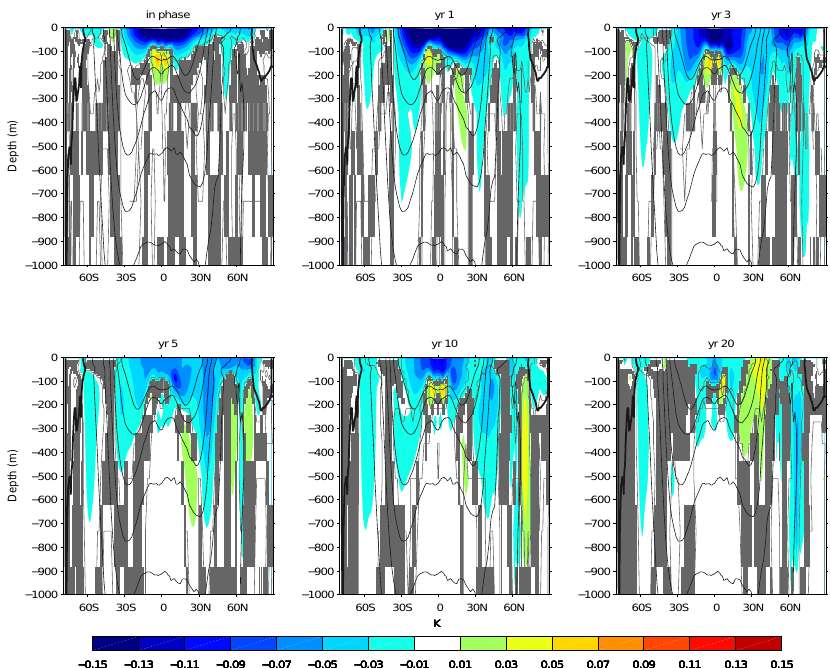
Fig. 6. Composites of anomalous zonally averaged oceanic temperature response at different time lags (in years). Shaded areas are not significant at the 20% level. Grey contours indicate anomalies significant at the 5% level. Dark contours show the zonal mean global temperature (contour interval is 3 ◦ C).